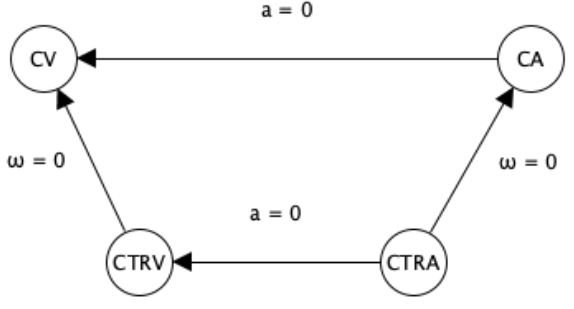
Figure 1. The applied motion models and their